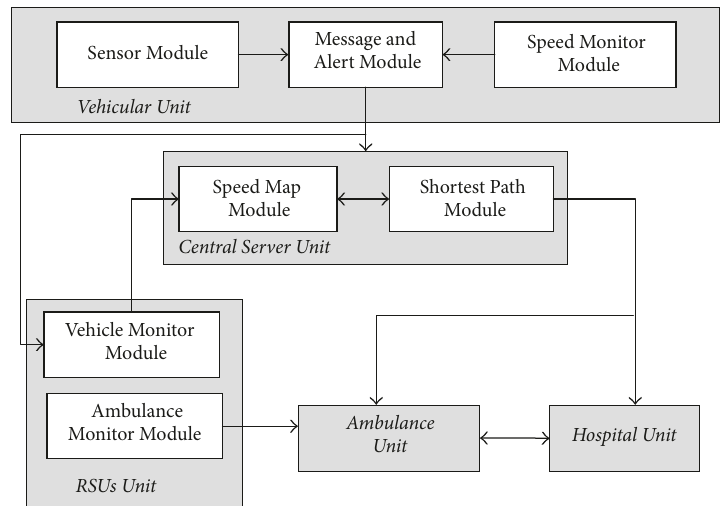
Figure 1: Model of accident management system.